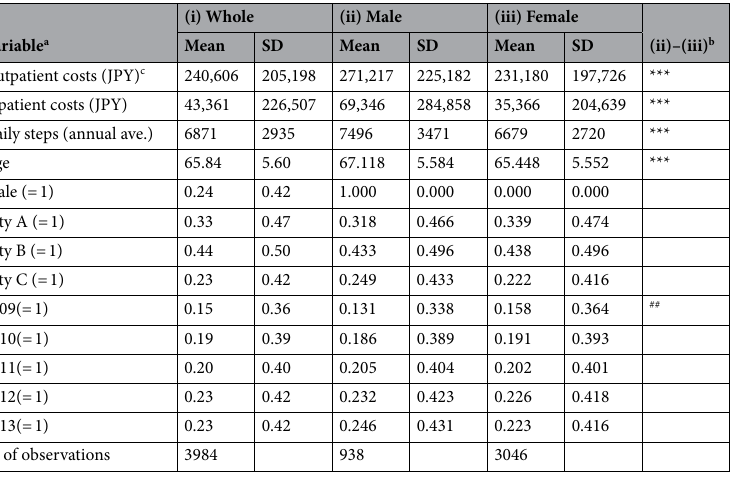
Table 1. Summary statistics. JPY Japanese Yen, Annual ave . Annual average, SD standard deviation. a (= 1) indicates dummy variable. b ***,** indicate the positive results of a t-test of equal means between two samples at the 1% and 5% significance levels, respectively. ###,## indicate the negative results of the t-test at the 1% and 5% significance levels, respectively. We use Welch’s method to test the difference of averages under the hypothesis of heteroskedasticity. c The sample size for inpatient costs is different (whole: n = 3991, male: n = 939, female: n =